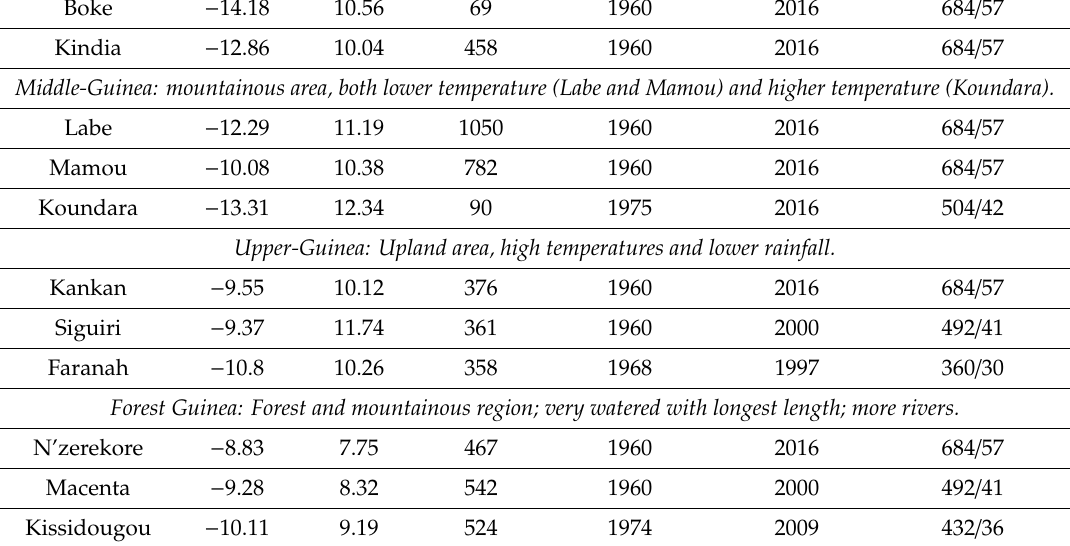
Table 1. The corresponding values of geographical information for the 12 weather stations used in the study along with availability of the temperature records in: Lower-Guinea (Conakry, Boke and Kindia); Middle-Guinea (Labe, Mamou and Koundara); Upper-Guinea (Kankan, Siguiri and Faranah) and Forest Guinea (N’zerekore, Macenta and Kissidougou) starting and ending years with available data for the surface monthly averaged temperatures in Guinea. Station Long ( ◦ ) Lat ( ◦ ) Alt (m) Starting Year Ending Year Lower-Guinea: lowland area, very watered and high temperatures because of mountains, urban and coastal e ff ects. Conakry − 13.37